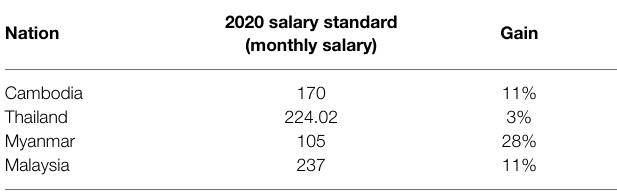
TABLE 2 | Changes of minimum monthly salary standards in some Southeast Asian countries.